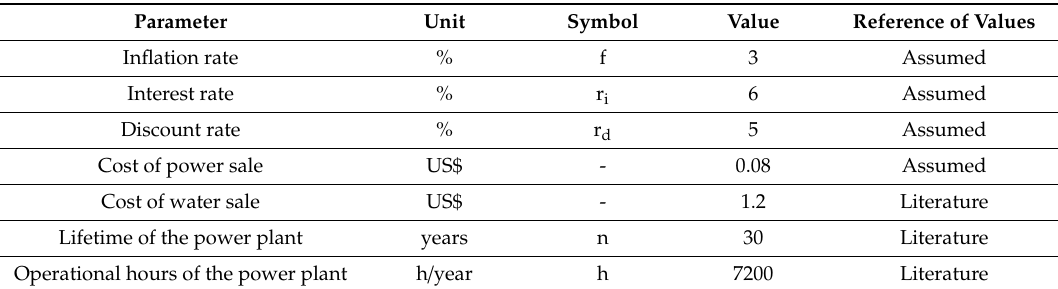
Table 7. Economic parameters used in the